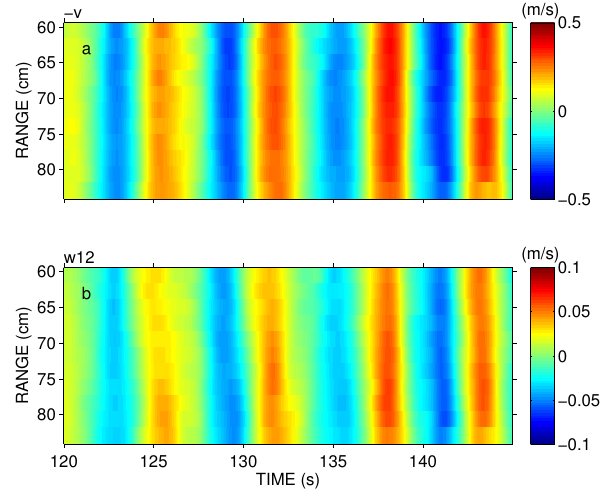
Figure 11. Wave-band velocity profiles from the MFDop: (a) cross- shore velocity, positive onshore; (b) vertical velocity, positive up. The bottom is the zero-velocity band starting at about 83 cm range. Note the transition in the v vs. w phase relationship with range: i.e. from quadrature far from the bed, to in-phase close to the bed. Data are from YD130.64: i.e. when the bed was quasi-flat prior to ripple formation (see Figure 6). See Figure 13 for the meaning of w12.